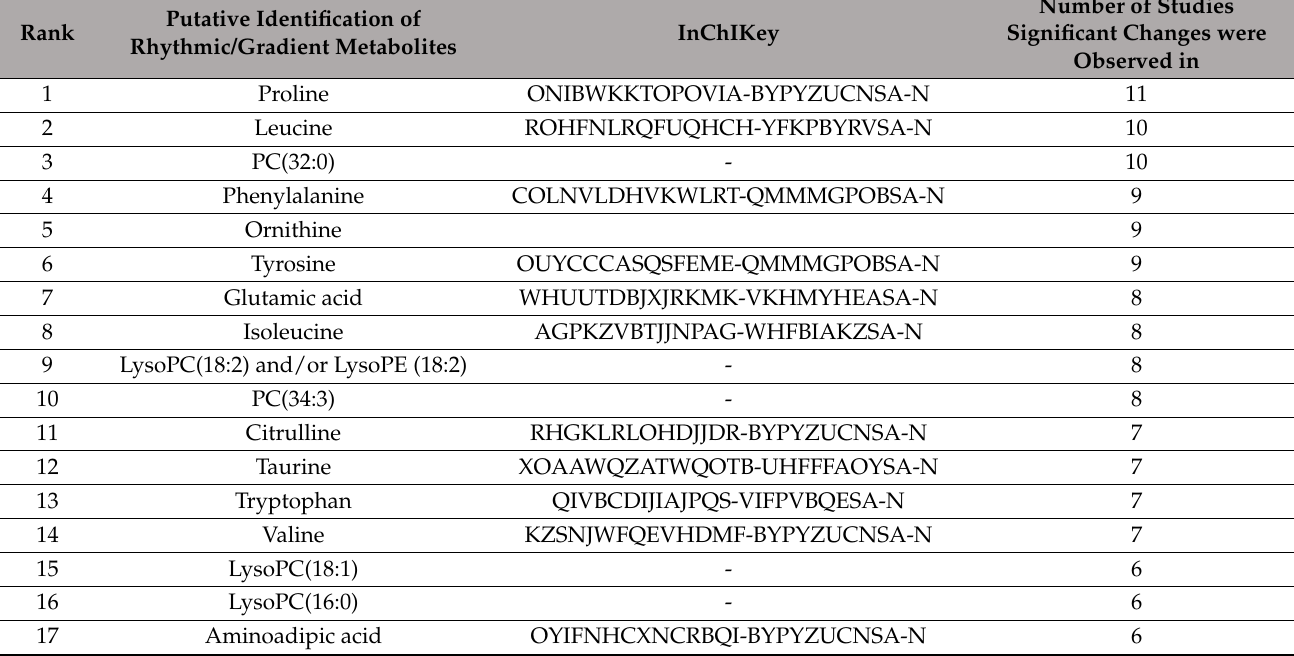
Table 7. Putatively identified metabolites, observed in five or more human metabolomics time course studies, that underwent significant time of day variation (rhythmic/gradient metabolites) in ranked order.